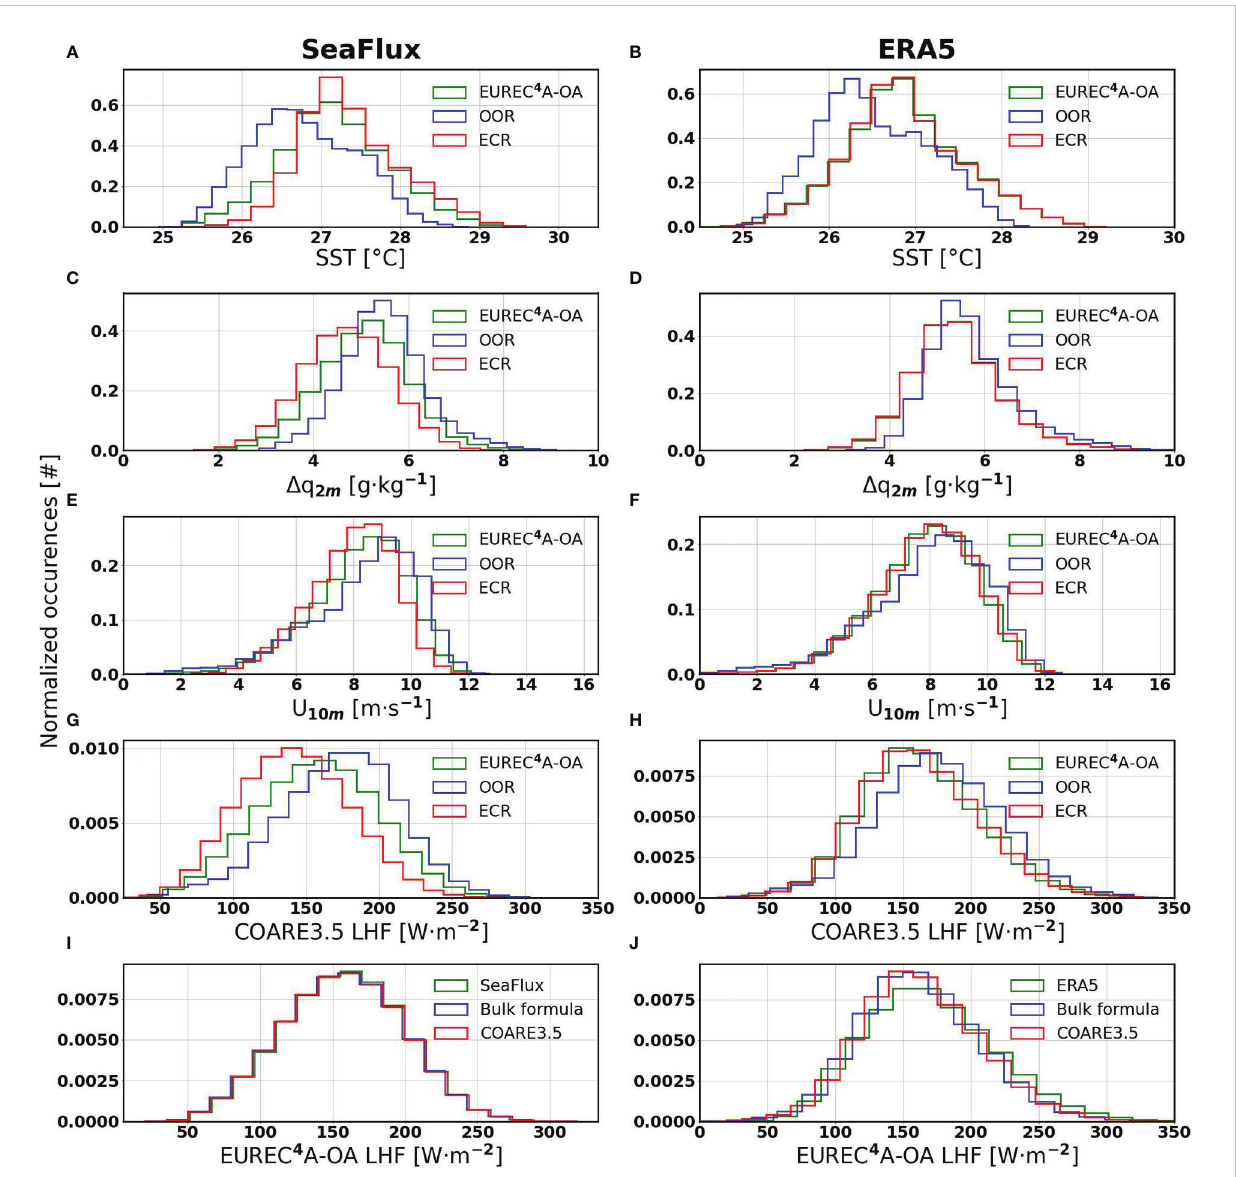
FIGURE 2 Histograms of the different variables analyzed in this paper for SeaFlux (left column) and ERA5 (right column). (A, B) represent the SST; (C, D) depict the 2 m speci fi c humidity de fi cit de fi ned as the difference between the saturation speci fi c humidity and q 2 m ; (E, F) illustrate the U 10 m distribution and (G, H) display LHF computed using COARE3.5. In all the plots hitherto mentioned the green curve is obtained considering the whole EUREC 4 A-OA box (5°-17° N, 60°-51°W), and the blue and red histograms are calculated over the OOR and ECR regions respectively as de fi ned in the main text and as shown in Figure 1. (I, J) represent the LHF given directly in the data sets (green), computed using eq. 1 (blue) and using COARE3.5 (red). All the histograms are constructed using daily averages of SeaFlux and ERA5 data in the 2008-2018 DJF